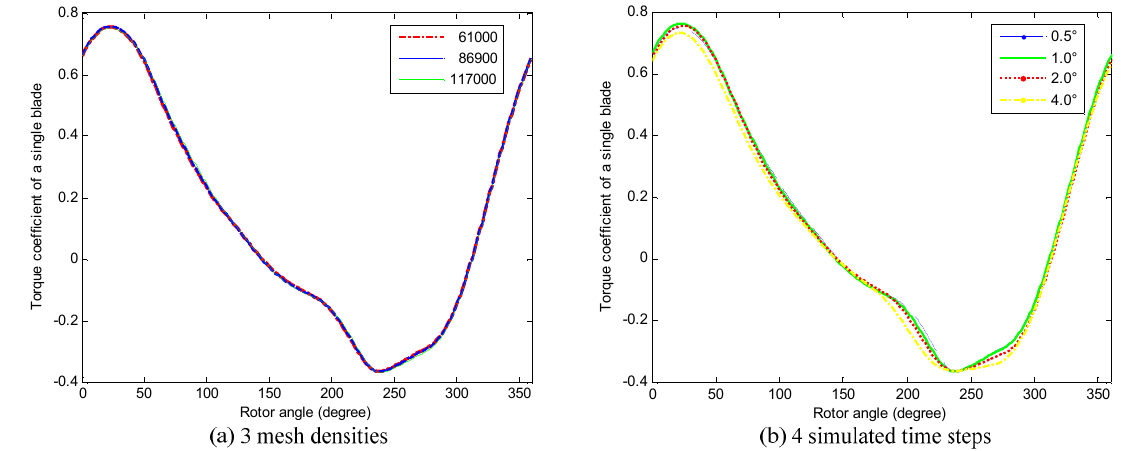
Figure 6. ( a ) Three mesh densities and ( b ) four time steps: comparison of the torque coefficient at different rotor angle.